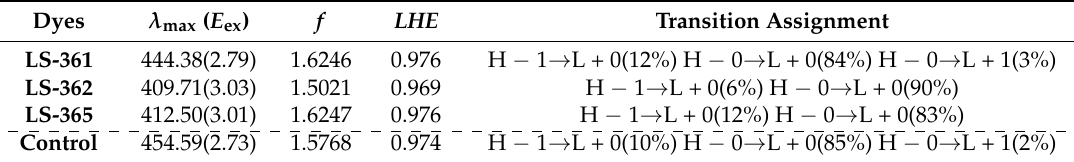
Figure 3. Calculated frontier molecular orbitals and energy levels of Control , LS-361 , LS-362 , and LS-365 dyes. Table 2. Selected excitation energies, electronic transition configurations, and oscillator strengths for LS-361 , LS-362 , LS-365 , and Control at B3LYP/6-311++G (d, p) level in acetonitrile.